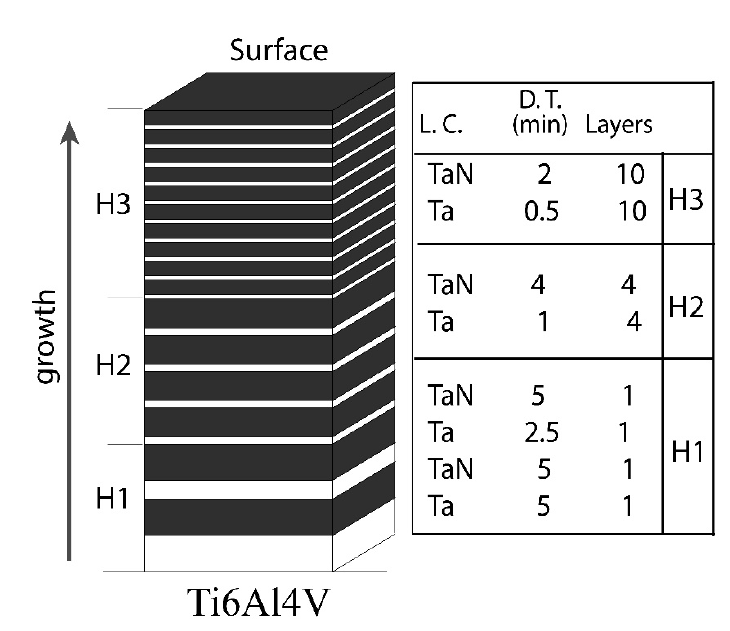
Figure 1. Schematic drawing of the deposition time used for each layer of the TaN / Ta coating, L.C (layer composition), D.T (deposition time).